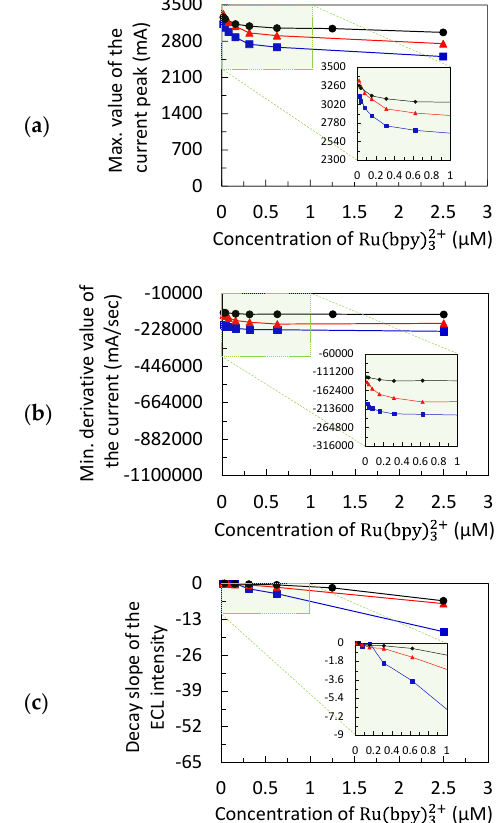
Figure 5. Measurements (black, red, and blue solid symbols are for repetitions 1, 2, and 3, respectively) and interpolated data (continuous lines) used to train the random forest (RF) algorithm: ( a ) maximum value of the current peak, C maxp , ( b ) minimum derivative value of the current, C mind , and ( c ) decay slope of the ECL intensity, ECL sl